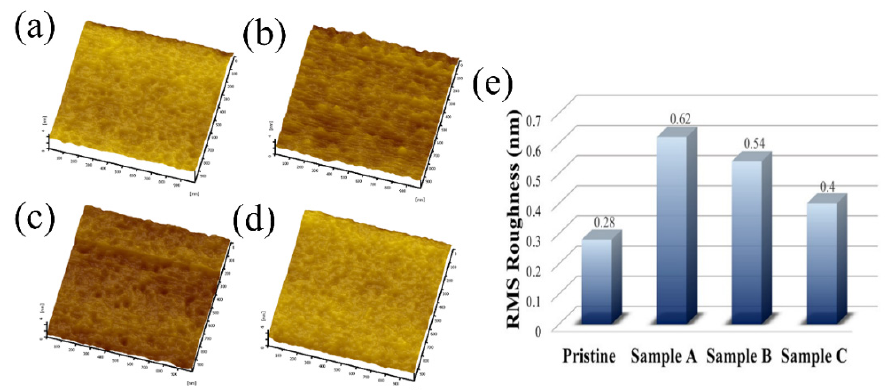
Figure 4. AFM images for the ( a ) pristine sample and samples ( b ) A, ( c ) B, and ( d ) C. ( e ). Surface RMS roughness measured for the pristine sample and samples A, B, and C.